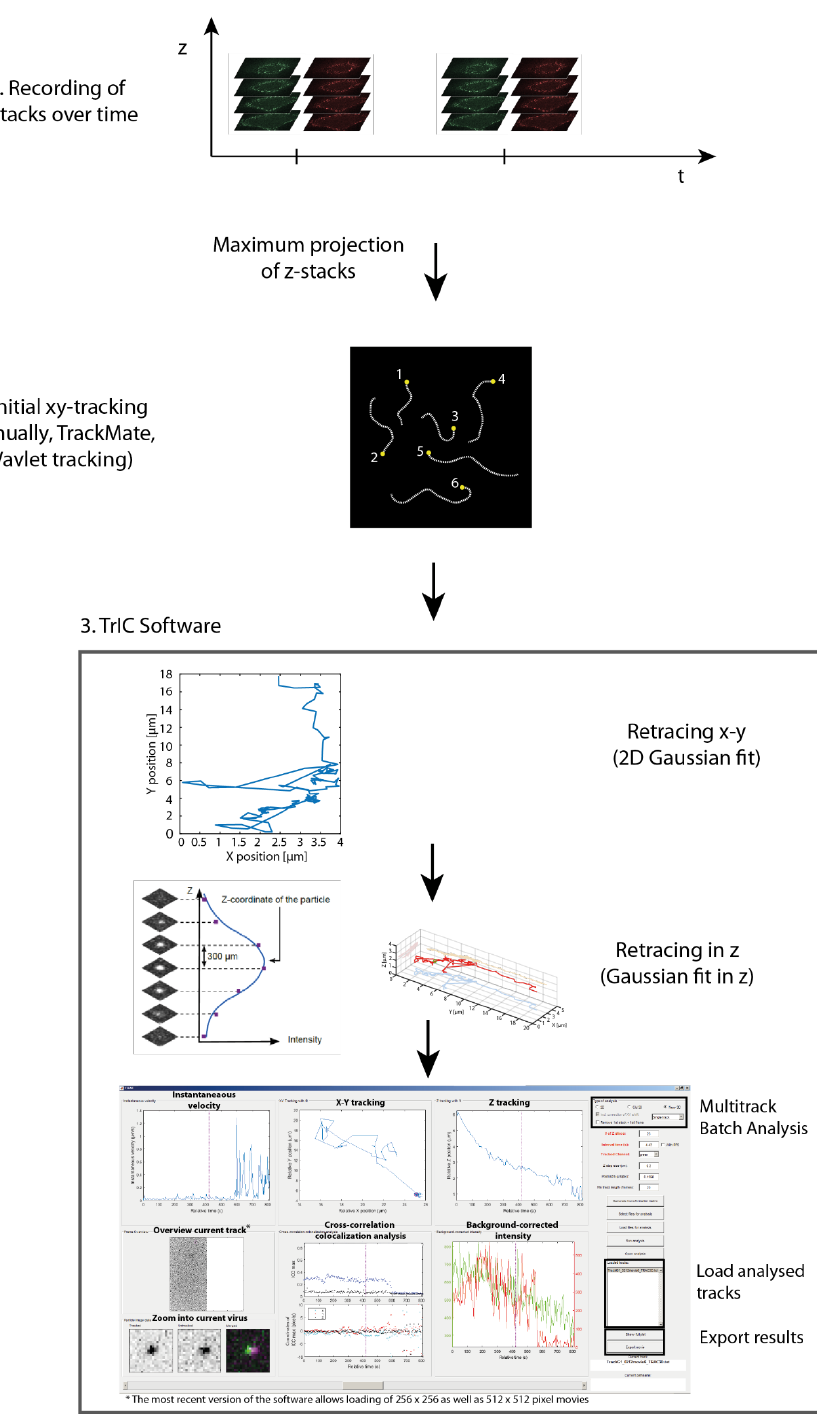
Figure A3. Data analysis via the TrIC software. Data was analyzed using the TrIC algorithm [30] in a home-written software in Matlab. The general workflow of the analysis and a screen shot of the data analysis program is shown. Starting in the top left, the program window shows: the instantaneous velocity, x - y projection of the trajectory, the z position as a function of time, frame overview, the image correlation analysis along the trajectory, a background-corrected fluorescence intensity of the two channels and images of the tracked and untracked channels and their overlay at the position of the cursor. Control parameters and functionalities in the program are given on the